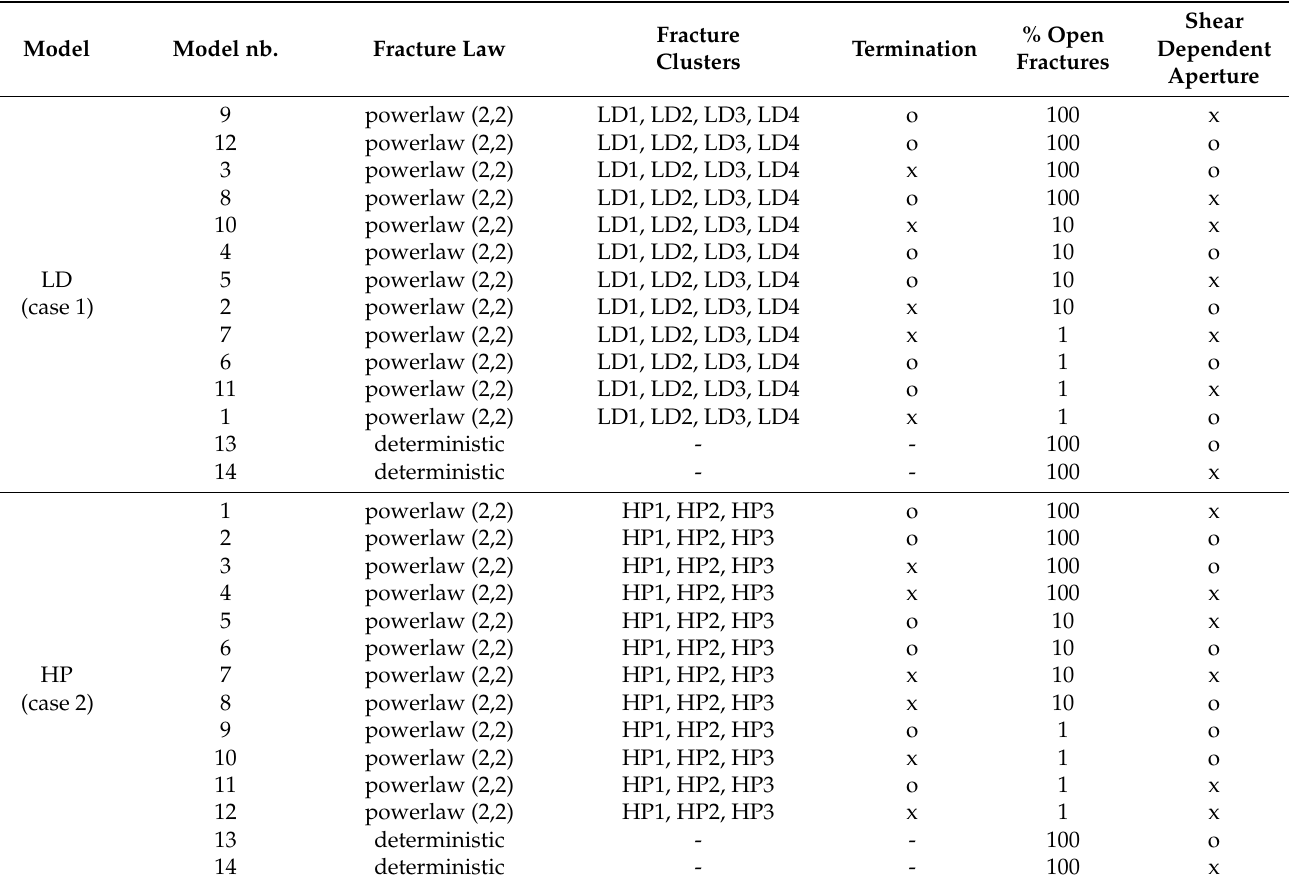
Table 5. Model features parametrisation, with fracture law used, and associated parameters, fracture clusters name (for fracture cluster properties, see Table 4), termination (with (x) or without (o)), percentage of open fracture considered, and aperture parametrisation (with (x) or without (o) shear- dependent